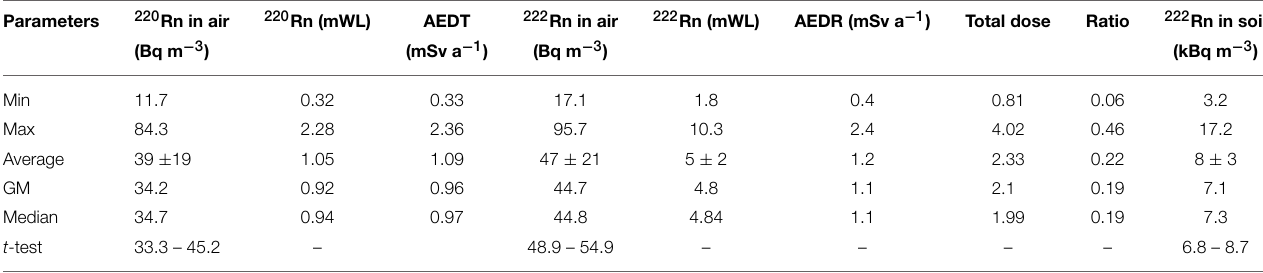
TABLE 3 | Statistical Parameters of 222 Rn and 220 Rn concentration in indoor air samples, 222 Rn concentration in soil samples.